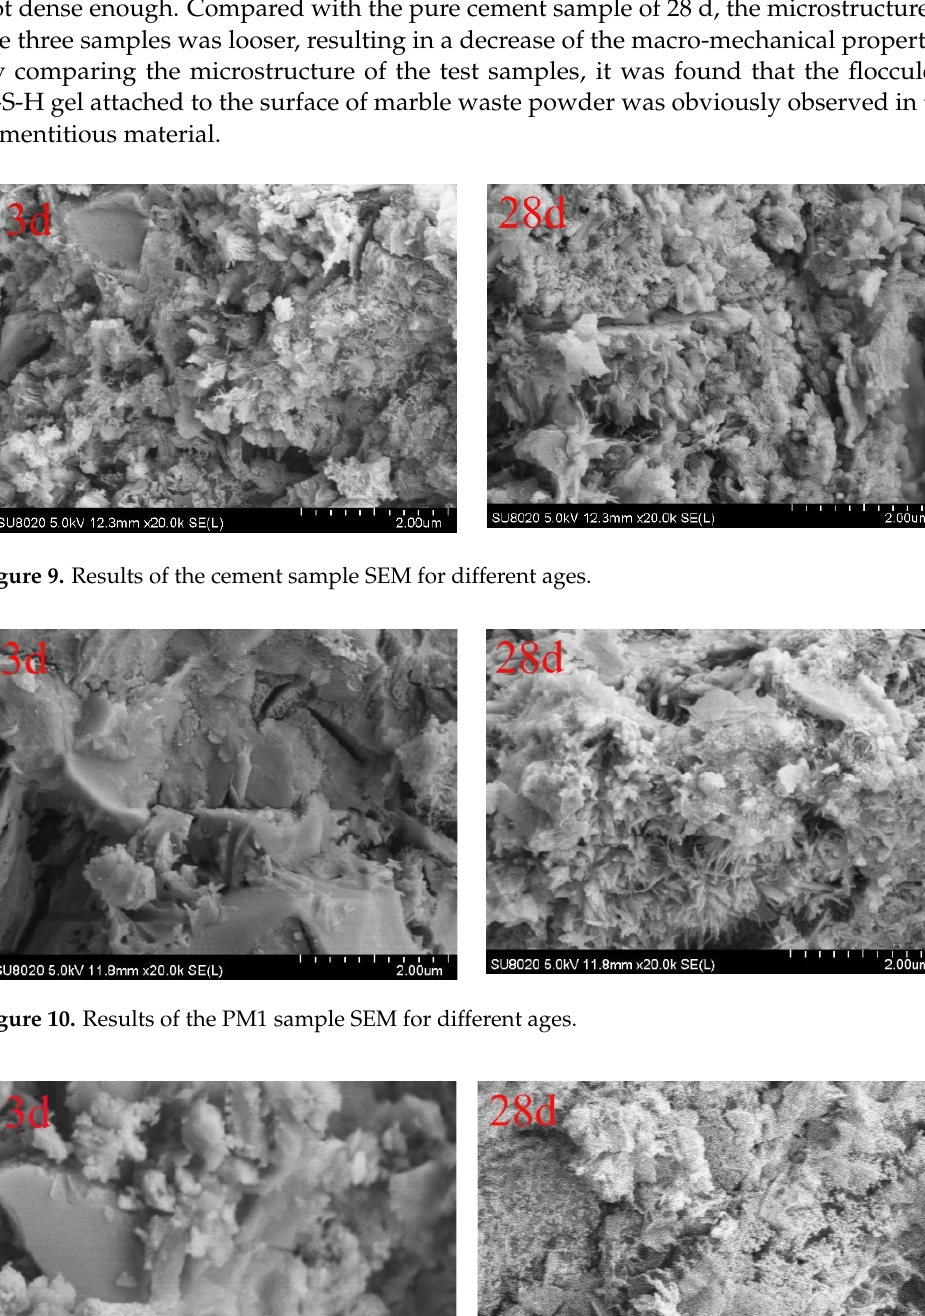
Figure 9. Results of the cement sample SEM for different ages.